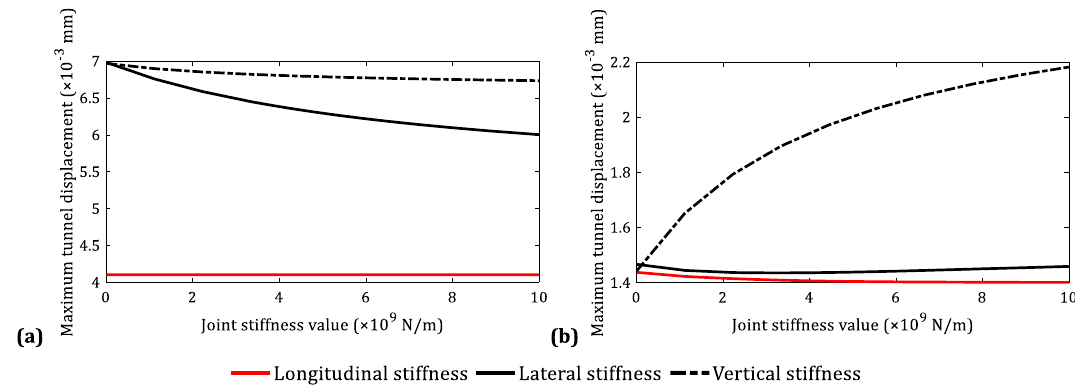
Fig. 21 Influence of tunnel segmental joint stiffness on tunnel lateral displacement: a tunnel bottom segment; b tunnel